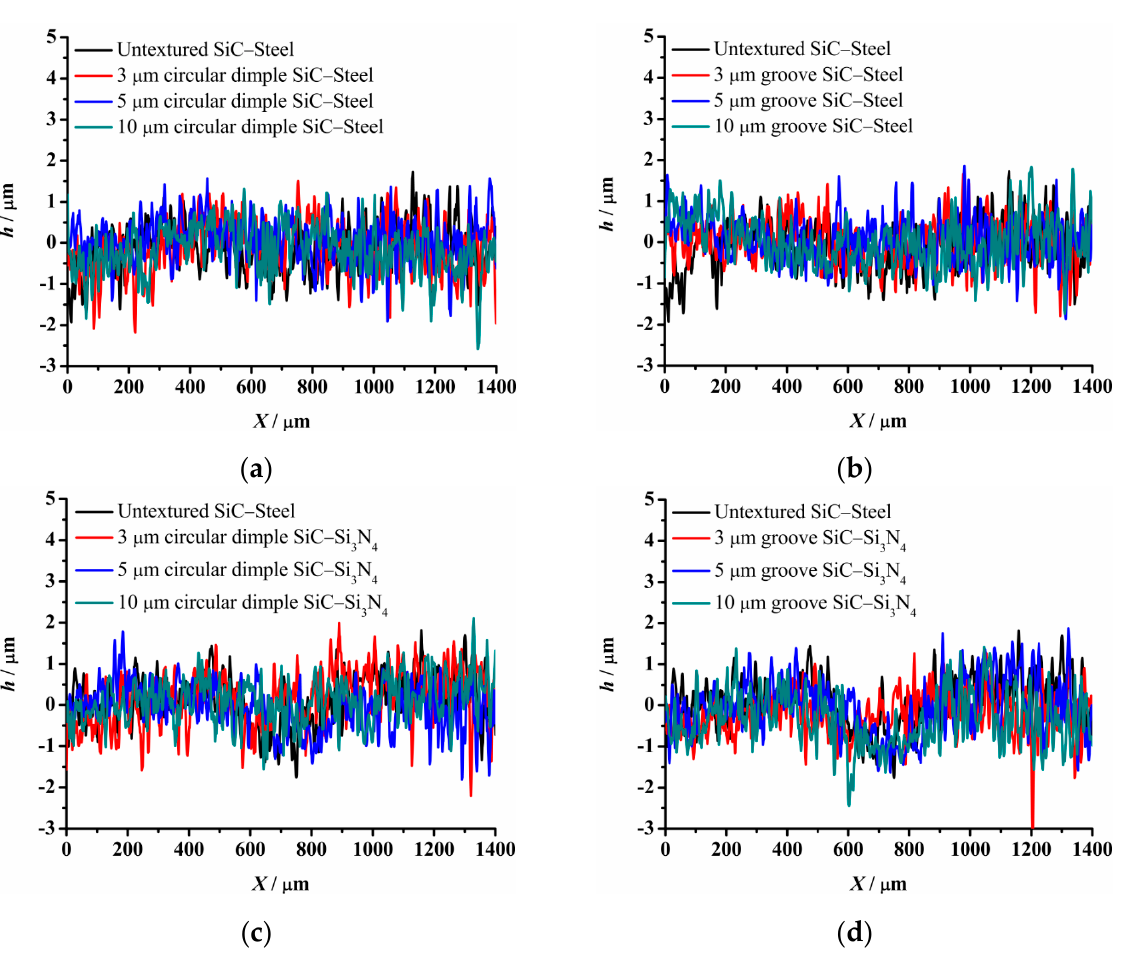
Figure 14. Cross section of wear scars under oil-lubricated conditions with a load of 75 N: ( a ) circular-dimple-textured SiC–steel ball, ( b ) groove-textured SiC–steel ball, ( c ) circular-dimple-textured SiC–Si 3 N 4 ball, and ( d ) groove-textured SiC–Si 3 N 4 ball.